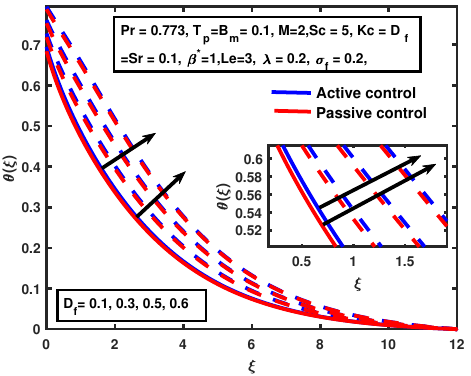
Figure 7. The impact of θ ( ξ ) on Dufour D f .